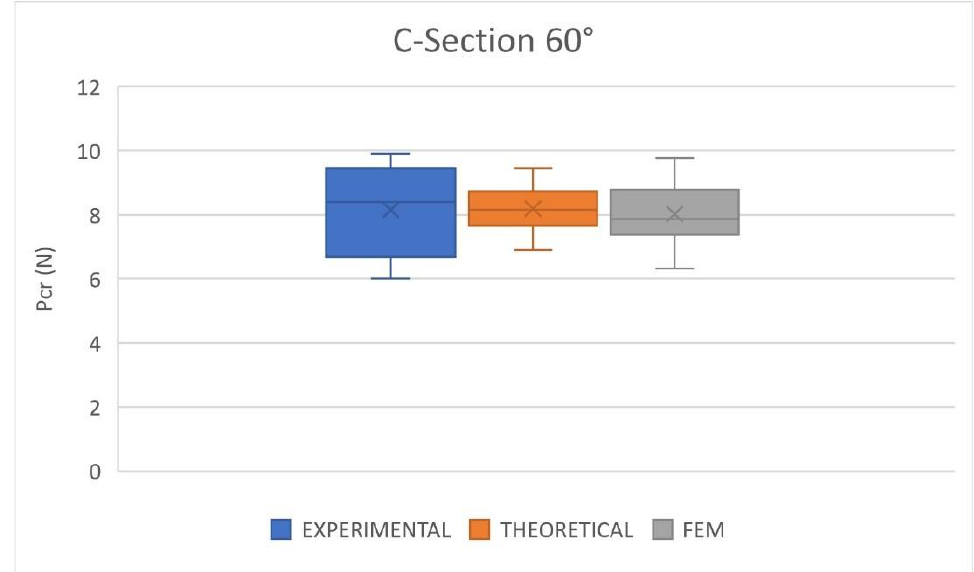
Figure 10. Critical buckling load. Comparison between experimental, theoretical and FEM results. C60 cross-section.